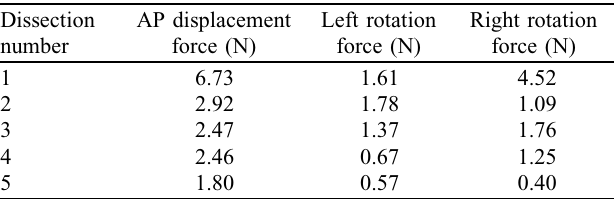
Table 2. Force in Newtons (N) required to cause 3 mm of anterior- posterior (AP) displacement and 10 mm of lateral rotation in one of the eight